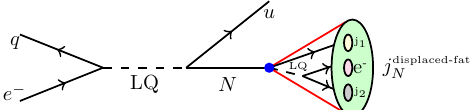
Figure 2 . Sample Feynman diagram for the model signature at the LHeC, the blue circle indicates displaced N decay.